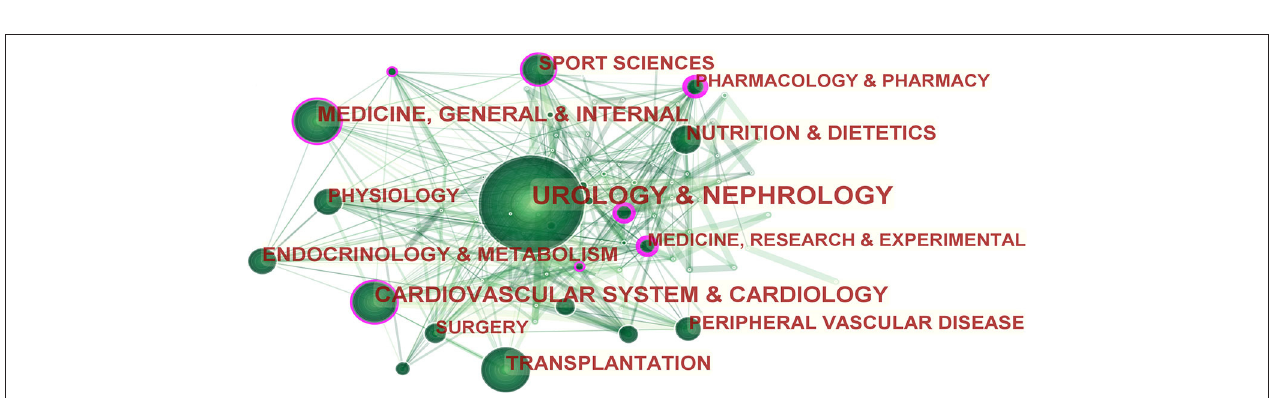
FIGURE 3 | Subject category co-occurrence of publications about exercise-based renal rehabilitation. Circled nodes represent output subjects; connections between nodes indicate cooperative